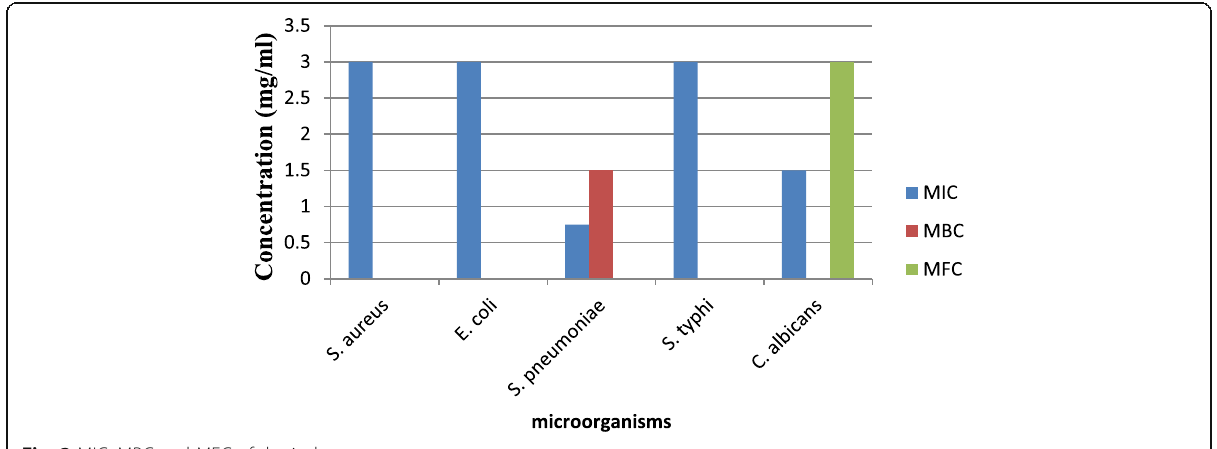
Fig. 3 MIC, MBC and MFC of the